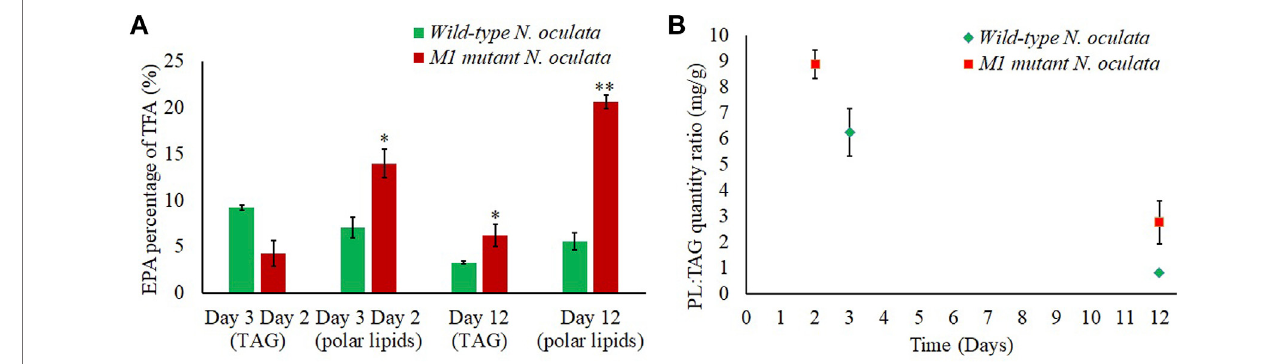
FIGURE 9 | Fatty acid content. (A) EPA percentages (%) of TFA in polar lipids and TAG at day 2 (M1 mutant), day 3 (wild-type), and day 12 (wild-type and M1 mutant) N. oculata . (B) Polar lipid (PL):TAG quantity ratio (mg/g) at day 2 (M1 mutant), day 3 (wild-type), and day 12 (wild-type and M1 mutant) N. oculata . Mean ± standard deviation is shown (n = 3) and t-tests determine the statistical signi fi cance ( p < 0.05 [*]; p < 0.01 [**]; p < 0.001 [***]) for EPA content in the M1 mutant strain compared to the wild-type